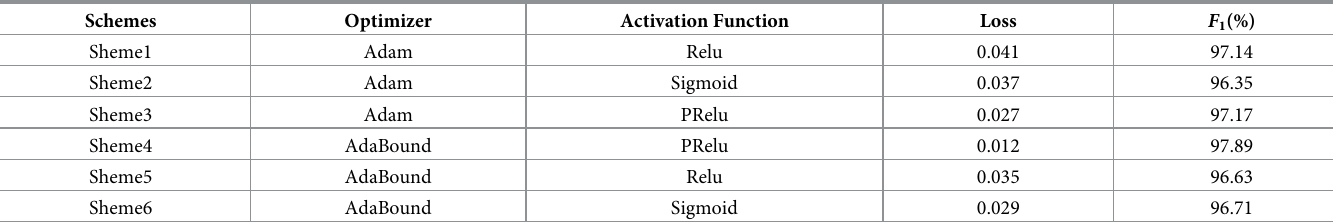
Table 4. Scheme configuration of optimizer and activation